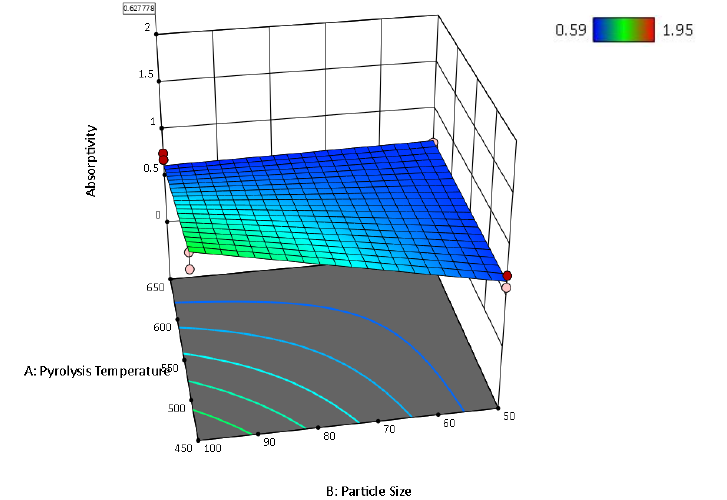
Figure 17. Surface response of the water absorptivity of switchgrass biocarbon-filled composites as a function of pyrolysis temperature and particle size when the particle loading is 20%.